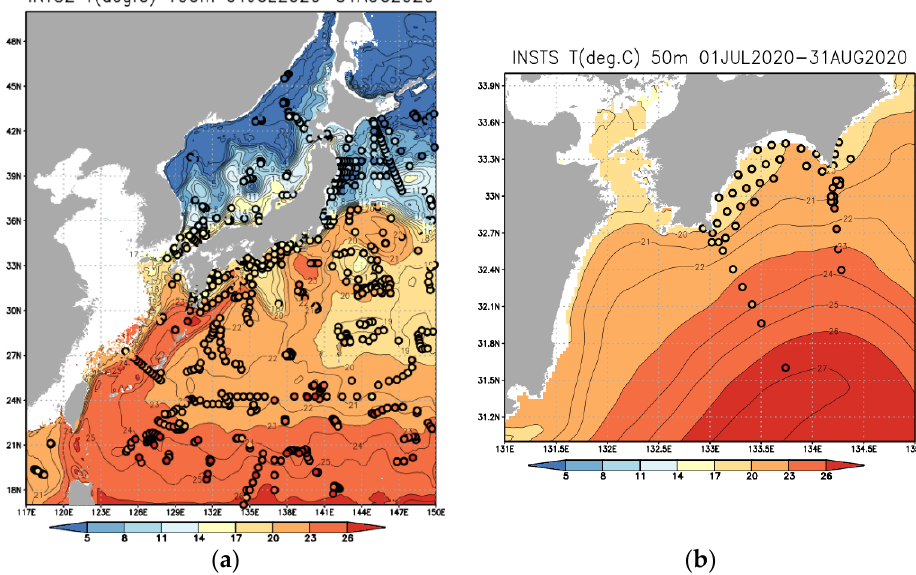
Figure 11. Mean temperature of the INSTS case for the period from 1 July to 31 August 2020. ( a ) The model region at 100 m depth. ( b ) Around Tosa Bay at 50 m depth. Open circles denote the locations of temperature observed during the same period archived at GTSPP ( a ) and provided from Kochi Prefecture Fishery Research Agency ( b ) with the color shade denoting temperature of the in situ data. Note that the ocean current velocities were also measured at the locations denoted by the open circles shown in ( b ).